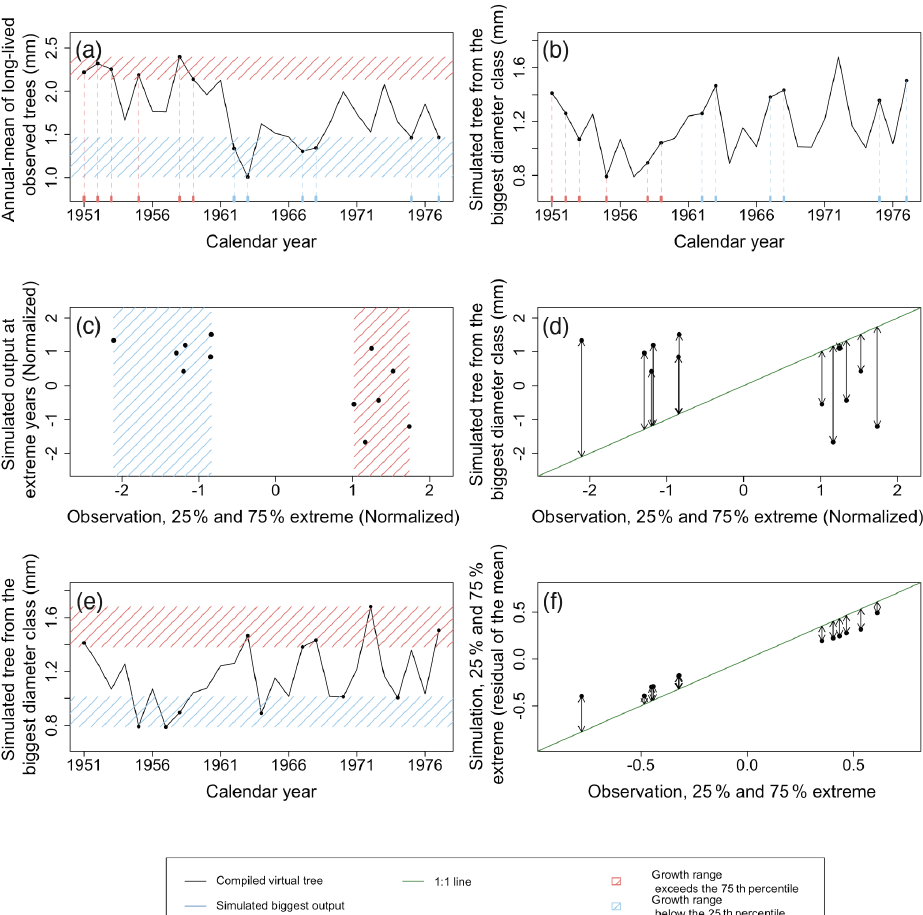
Figure 8. Example of the major steps in calculating the metrics of the benchmark for extreme-growth events. In this benchmark, extreme growth is defined as the first and last quartiles in TRW ordered by calendar year and averaged over the individual trees’ records (a) . The red shaded area and ticks represent observations exceeding the 75th percentile, and the blue shaded area and ticks represent observations below the 25th percentile (a) . The TRW simulated for the largest diameter class are then extracted for the years identified in panels (a) and (b) . Both observations and simulations were normalized to remove the difference in the range of values between configurations. These normalized values correspond to the x and y axis in panels (c) and (d) for the observations and simulations respectively. Subsequently, the similarity between simulations and observations was tested by calculating the distance from the 1:1 line (shown in green in panel d ), which is equivalent to the RMSE for years with extreme growth (d) . An additional metric is calculated in a similar way but by using both the 25th percentile and the 75th percentile of extreme values of the simulations and observations regardless of the year (e, f) . This test identifies if the simulation can reproduce the amplitude of TRW. The observations and simulations were not normalized to assess the absolute amplitude. Possible uncertainties from using reconstructed climate forcing were avoided by limiting the calculations of both metrics to the past 5 decades for which climate observations are available. Observations and simulation are from Pinus sylvestris site in Spain, archived as spai006 (Schweingruber, 2020). In this test case, the RMSE for extreme years (d) was 0.57mm, and the RMSE for extreme growth (amplitude; f ) was 0.03